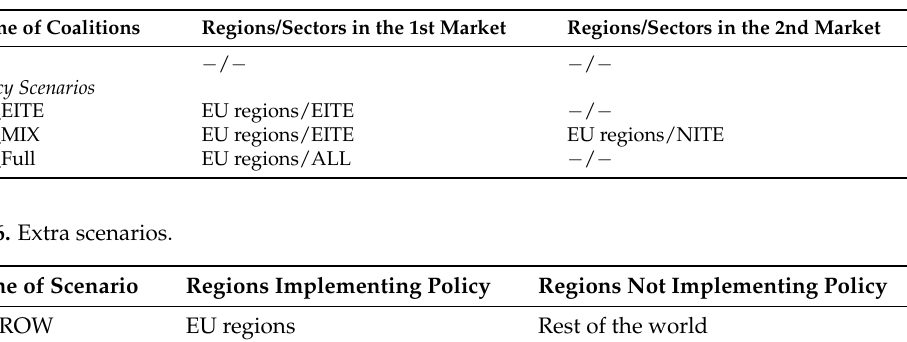
Table 5. Policy scenarios.